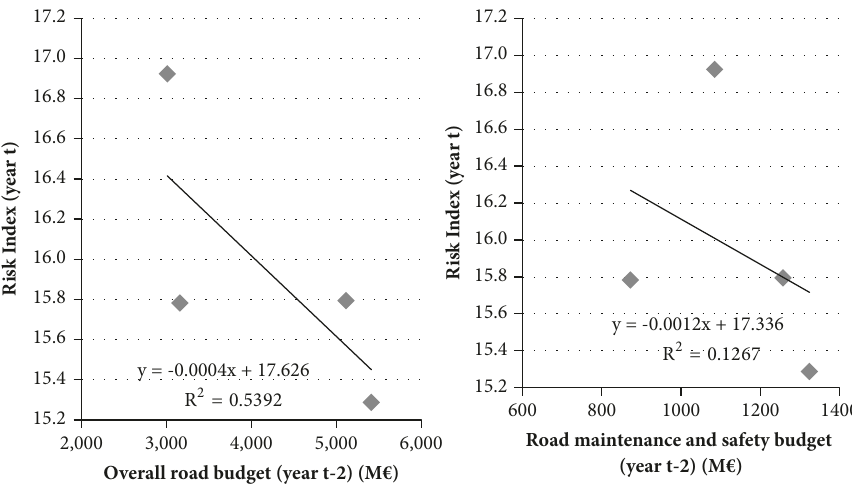
y = -0.0012x + 17.336